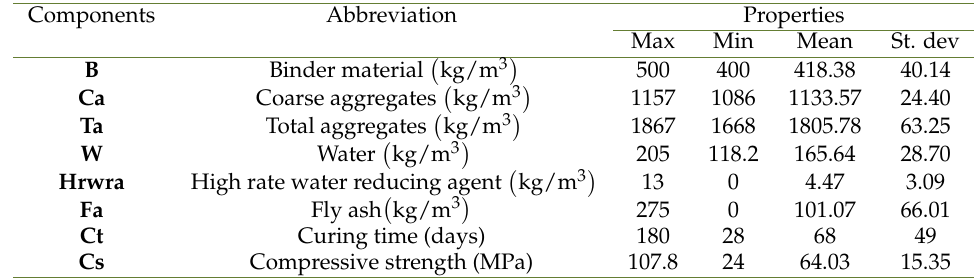
Table 2. The properties of data set components engaged in the modeling process Components